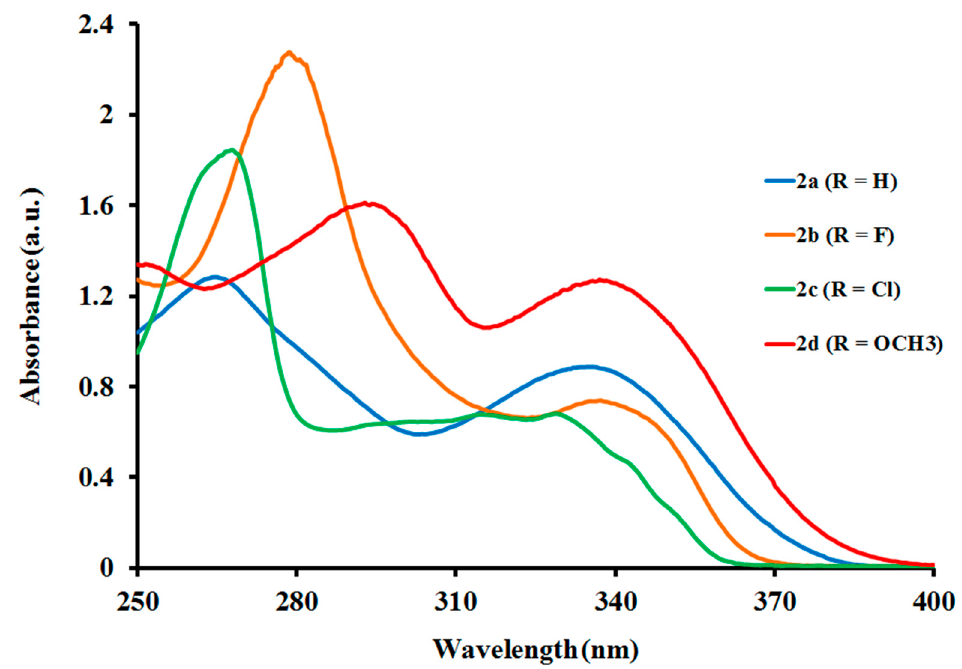
Figure 1. UV-Vis Absorption spectra of ( 2a – d ) in chloroform (concentration 1.0 × 10 − 3 mol/L).